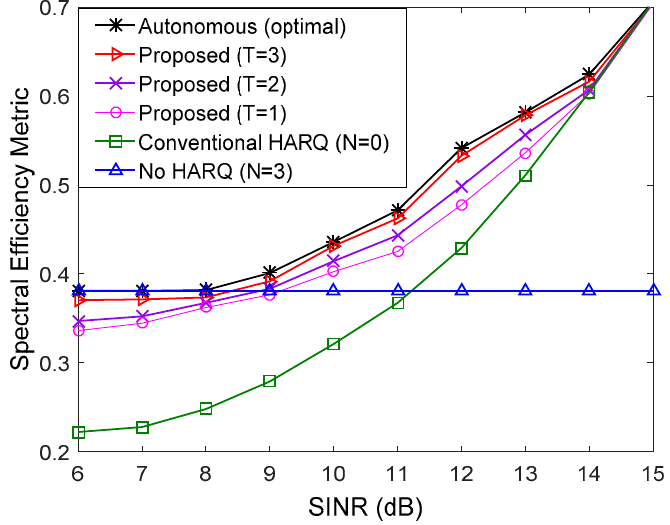
Figure 4. Comparison of spectral efficiency when K = 10, MCS level is 8, and all users have the same downlink SINR.